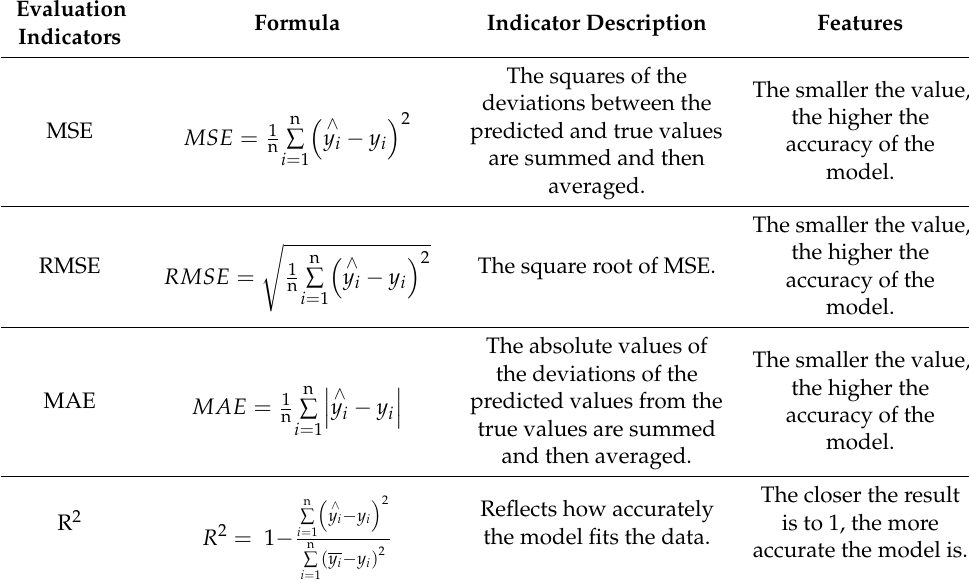
Table 1. Model performance evaluation